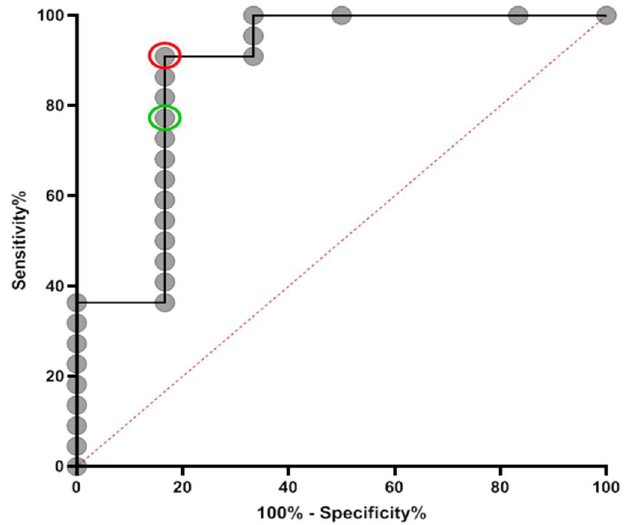
Figure 4. ROC curve for Abbott at specification of samples taken >100 days post-PCR result. The new cut-off (sensitivity = 90.91% (95% CI: 70.84–98.88%), specificity = 83.33% (95% CI: 35.88–99.58%)) and manufacturer’s cut-off (sensitivity = 77.27% (95% CI: 54.63–92.18%), specificity = 83.3% (95% CI: 35.88–99.58)) are represented by red and green circles, respectively. Data are presented for 22 RT-PCR-positive samples and 6 known RT-PCR-negative samples. Area under curve = 0.878, SE: 0.0991, 95% CI: 0.6845 to 1.000.